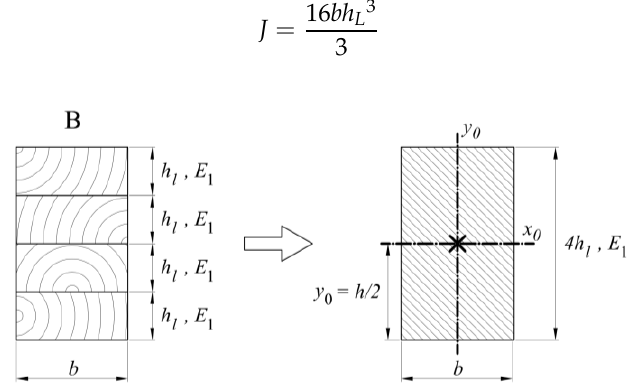
Figure 21. Cross-section of B-type samples, including the parameter notation used in the text.